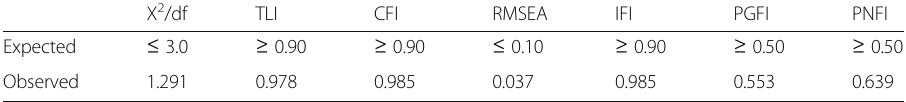
Table 7 Fit statistics of the structural model X 2 /df TLI CFI RMSEA IFI PGFI PNFI Expected ≤ 3.0 ≥ 0.90 ≥ 0.90 ≤ 0.10 ≥ 0.90 ≥ 0.50 ≥ 0.50 Observed 1.291 0.978 0.985 0.037 0.985 0.553